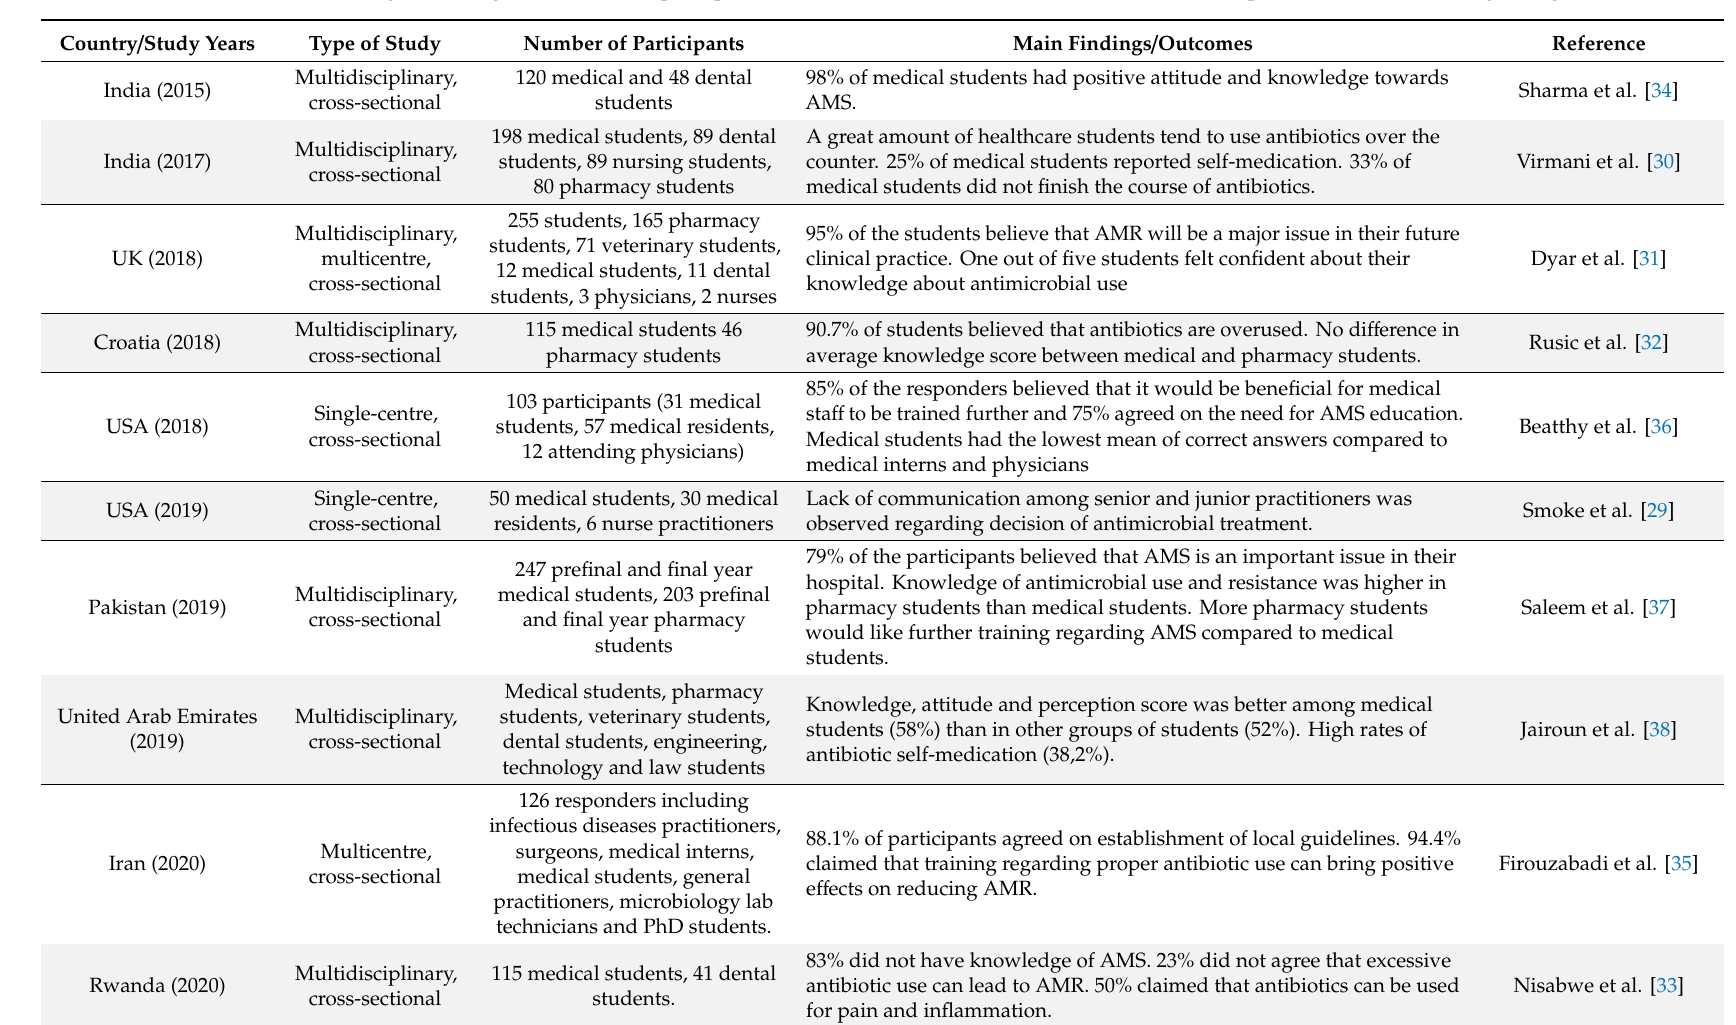
Table 2. Studies assessing knowledge, attitudes and perceptions of medical students as well as other healthcare professional students regarding